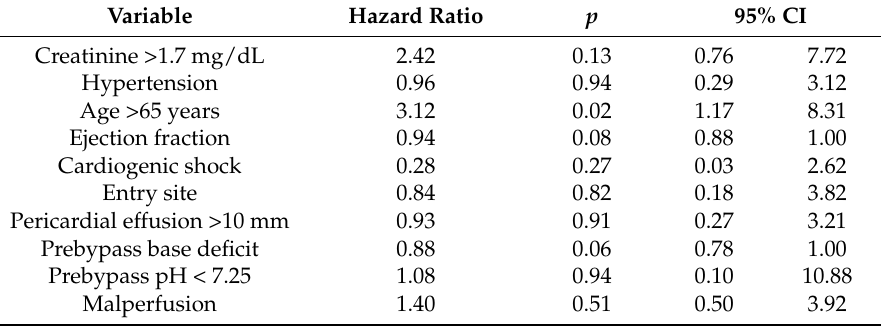
Table 4. Cox regression analysis for long-term (>30 days)